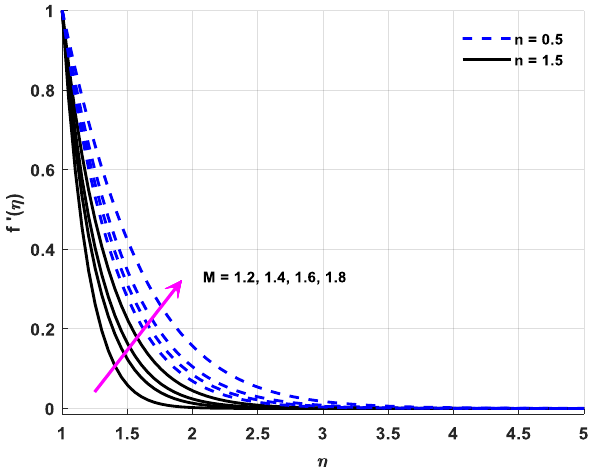
Figure 5. Fluid velocity profile variations owing to changes in M .